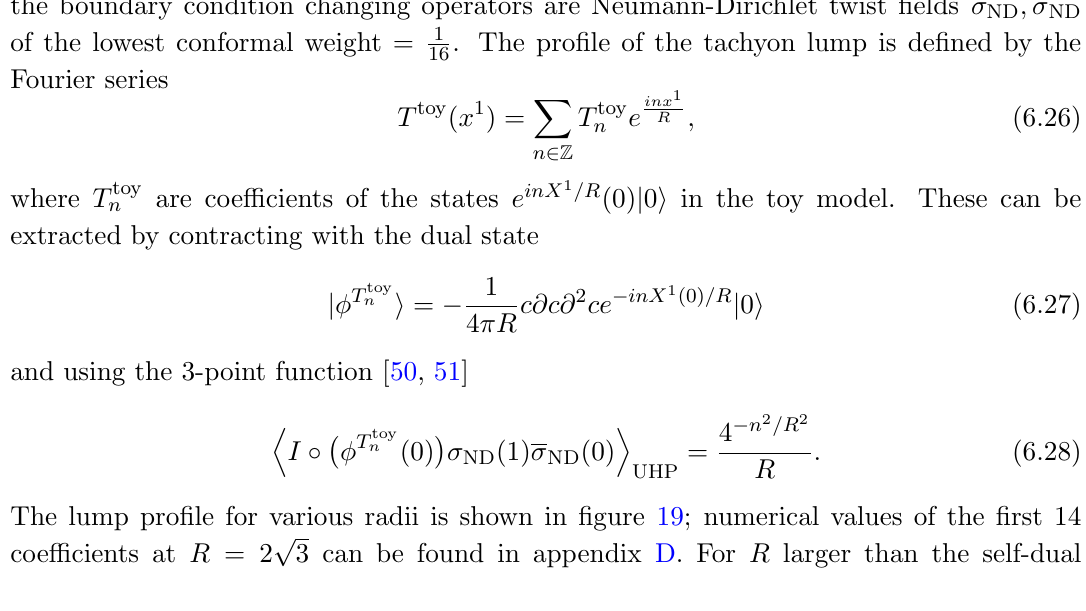
and the tachyon T toy for the toy model as a 1